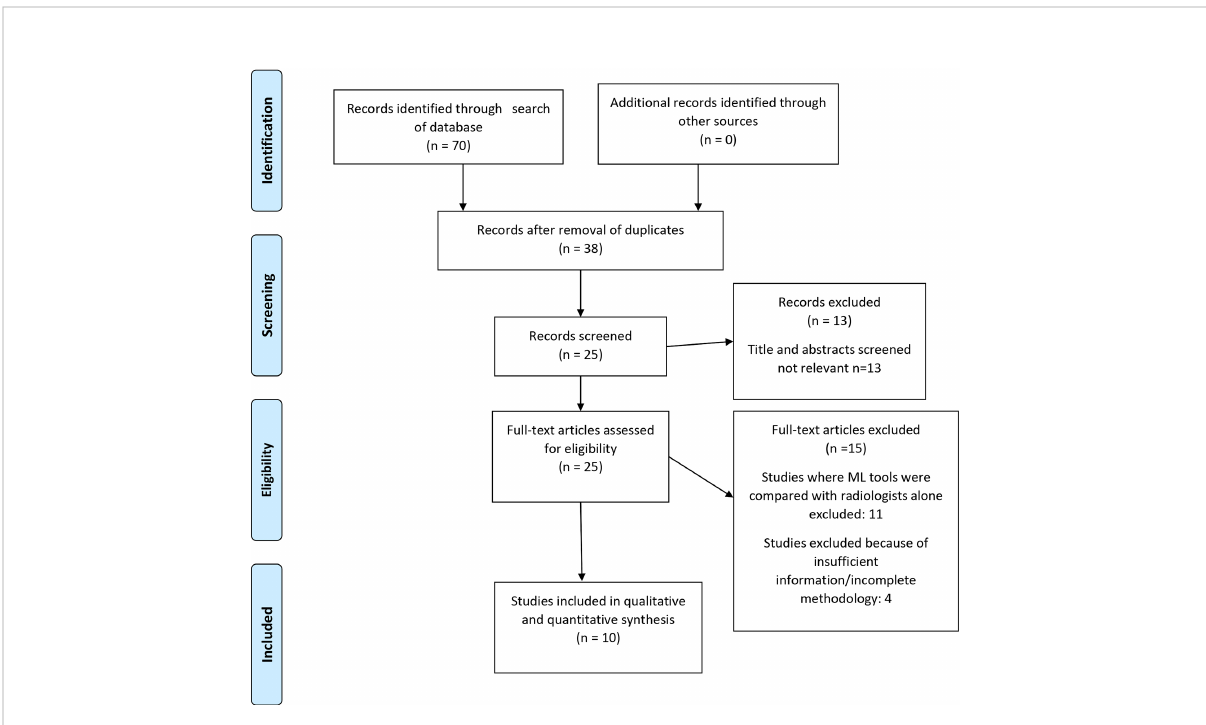
FIGURE 1 PRISMA 2009 Flow